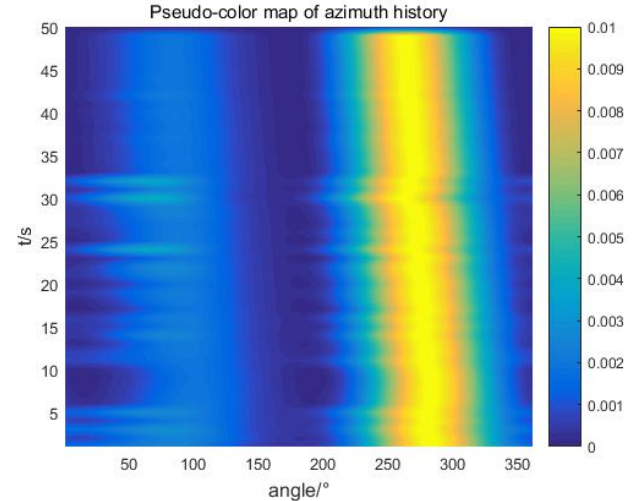
Figure 18. Power spectral density of ship noise.